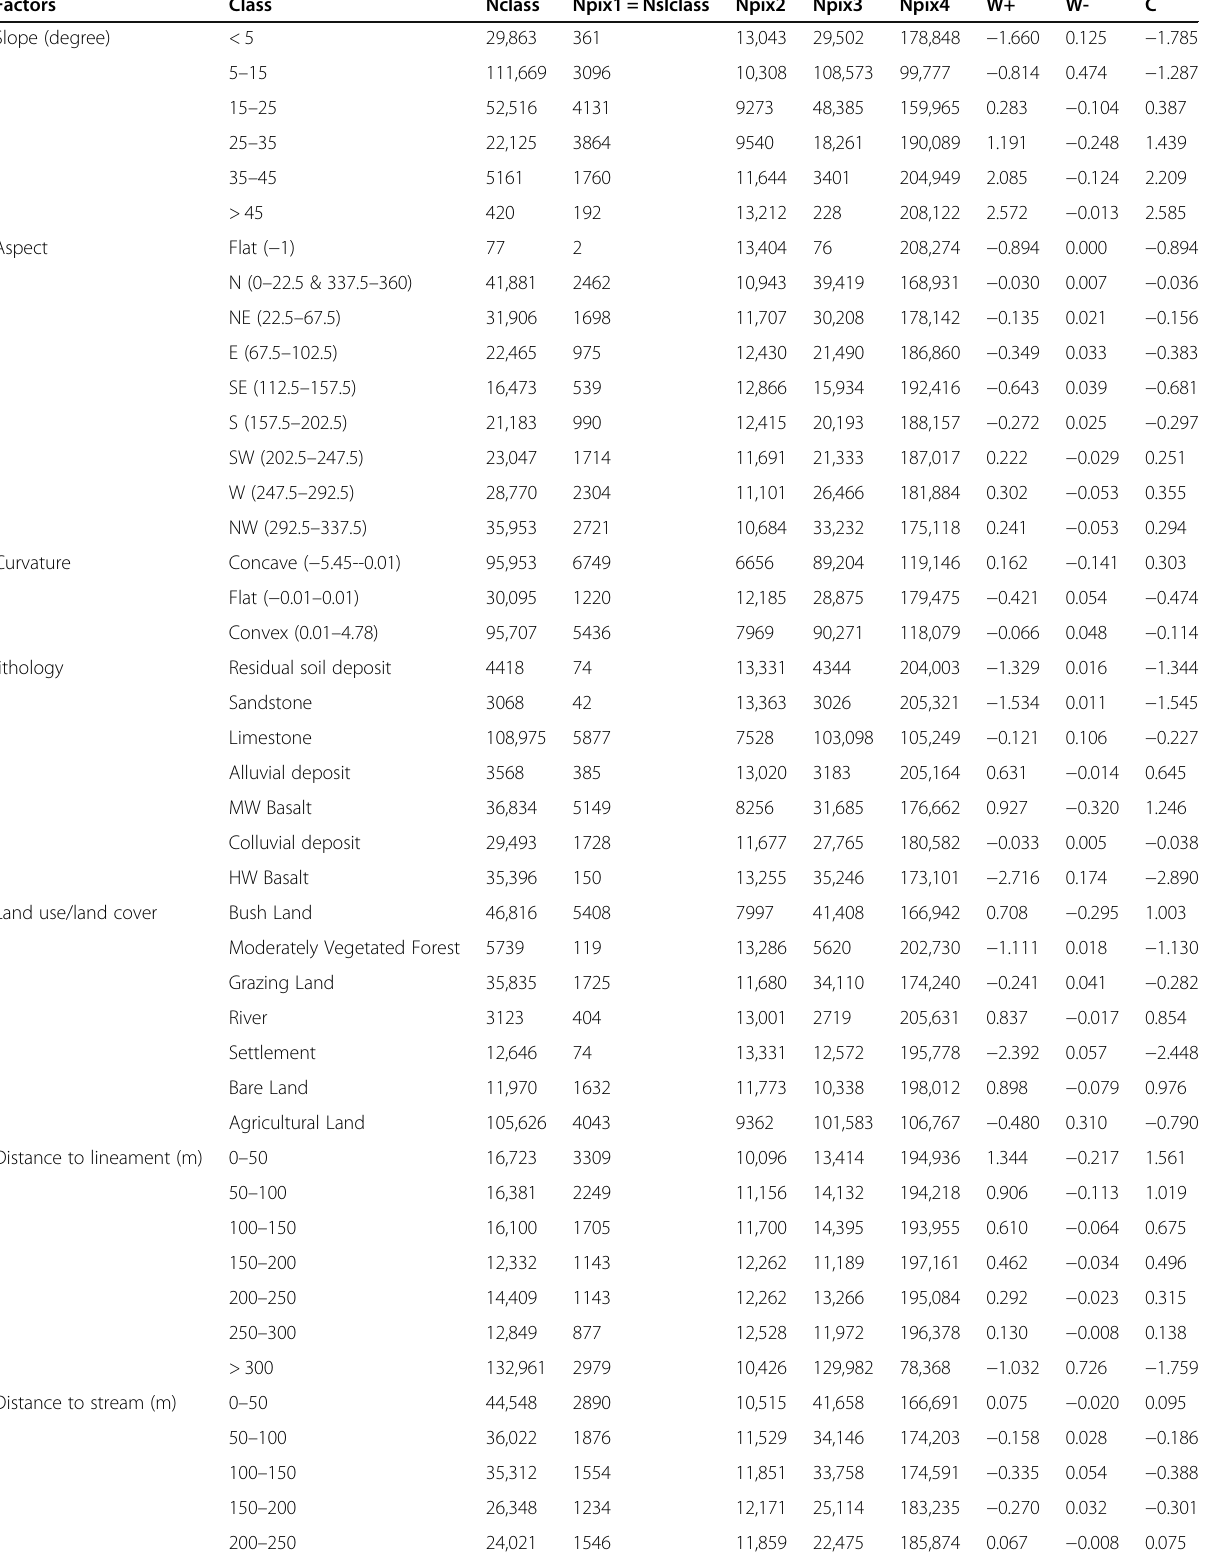
Table 1 The input data used in the analyses and results obtained from Weights of Evidence model